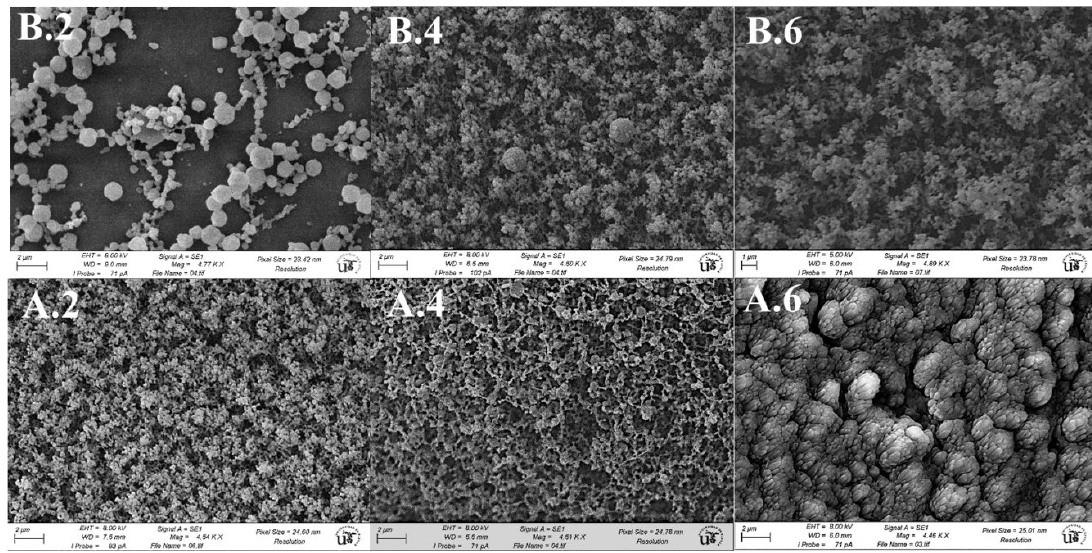
Figure 5. CryoSEM images obtained for egg yolk gel before thermal processing ( B.2 , B.4 , B.6 ) and after thermal processing ( A.2 , A.4 , A.6 ) at pH 2, 4, and 6, respectively.